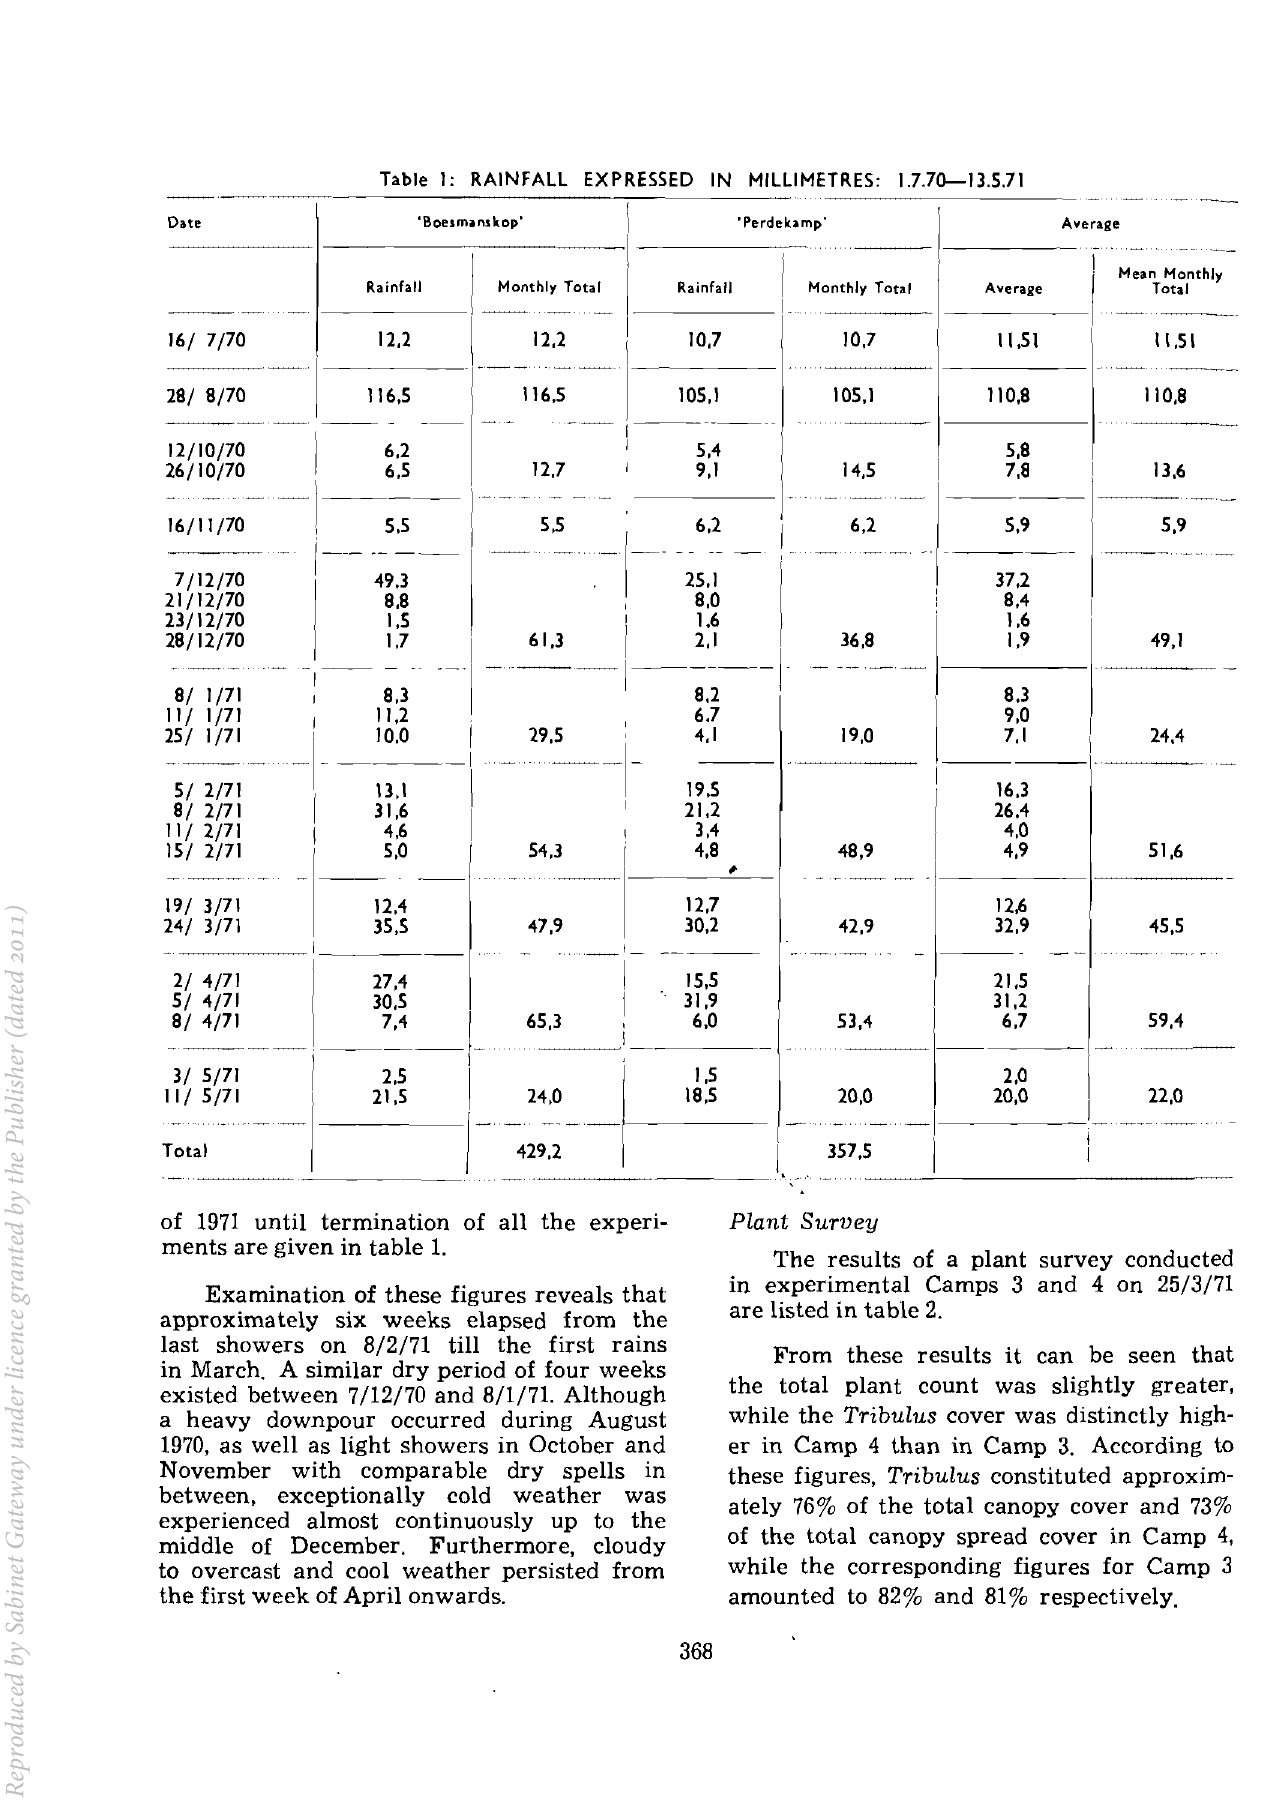
Table I: RAINFALL EXPRESSED IN MILLIMETRES: 1.7.70-13.5.71 I D.te 'Soesmanskop' ·Perdek.mp· Average R.inf.1I I Monthly Tot.1 R.inf.1I I Monthly Tot.1